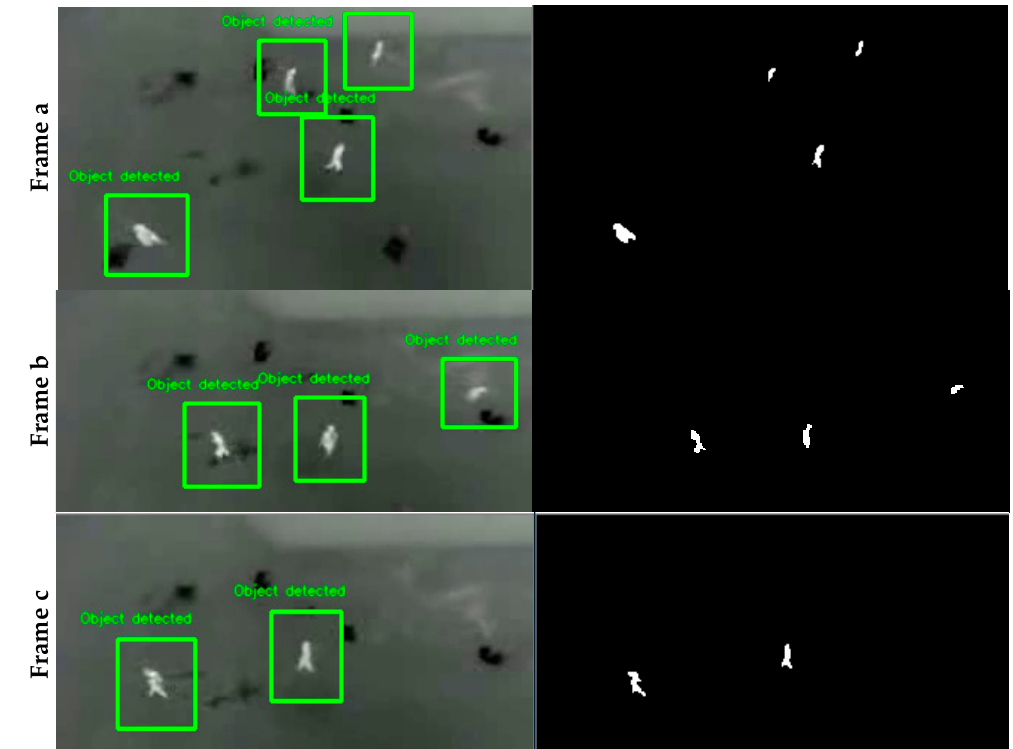
Figure 15. Left column: object detection results (green rectangles) as time progresses (frames ( a – c )) on the LITIV2012 dataset and applying the OBIA technique. Right column: the corresponding binary masks associated with the selected color and area thresholds.